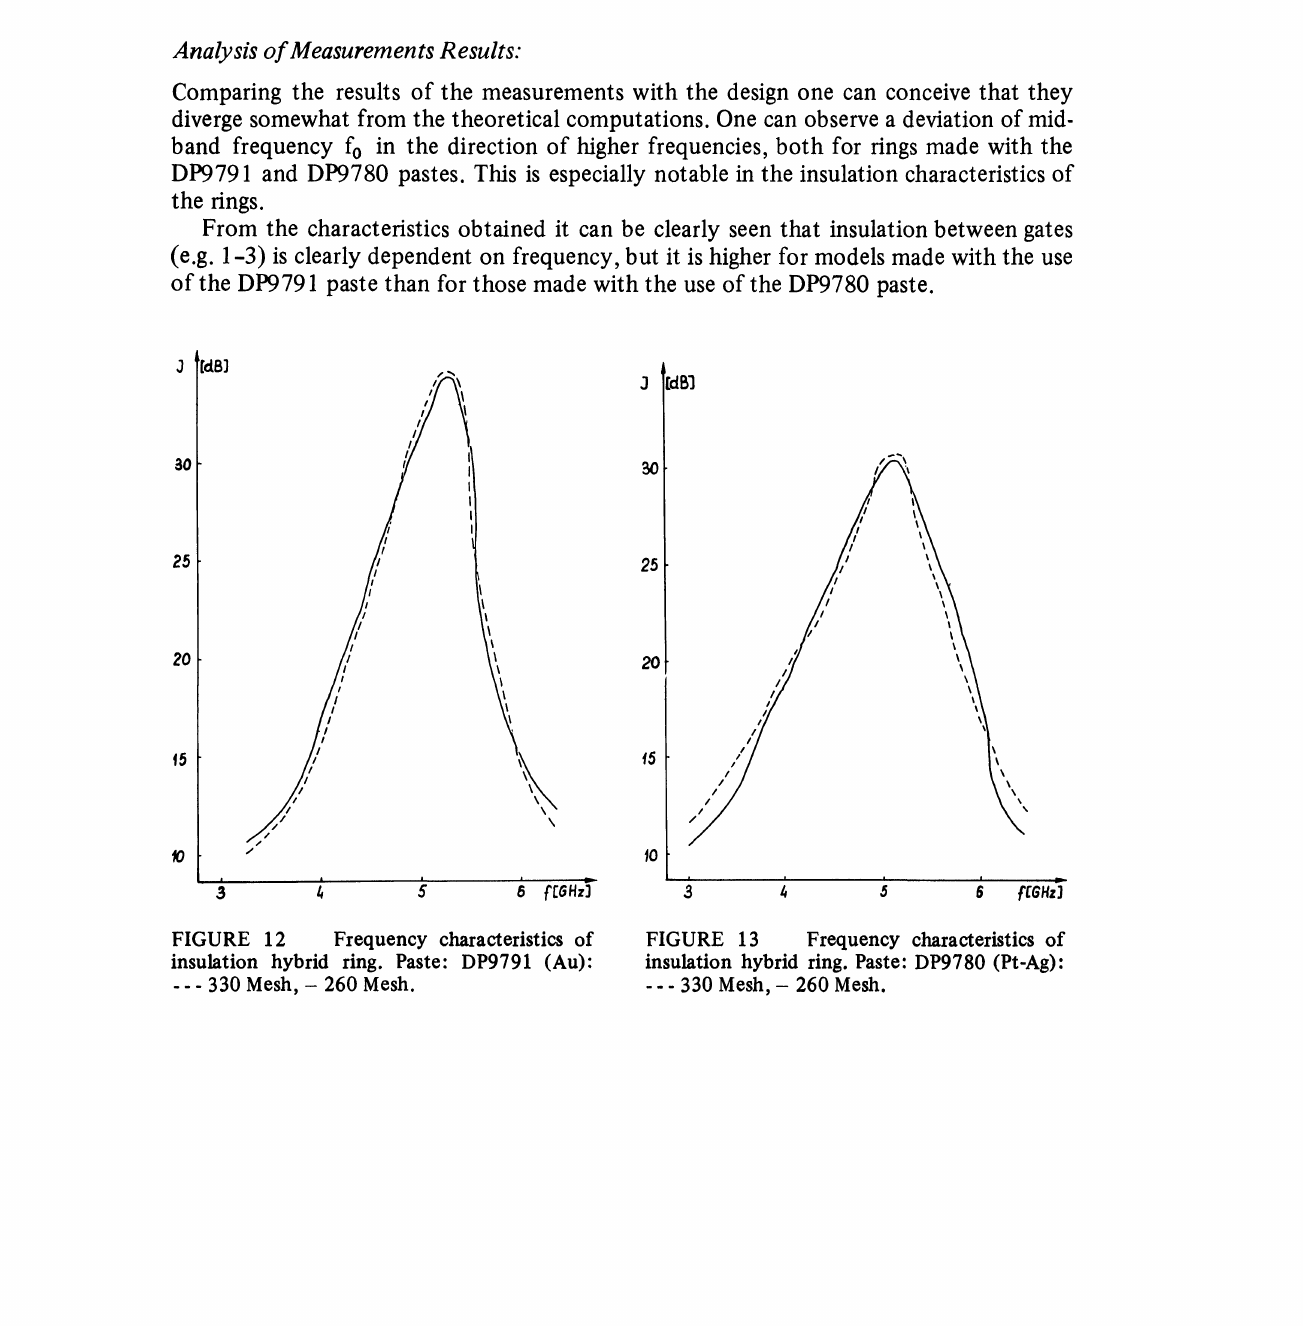
FIGURE 13 Frequency characteristics of insulation hybrid ring. Paste" DP9780 (Pt-Ag)" 330 Mesh,- 260 Mesh.